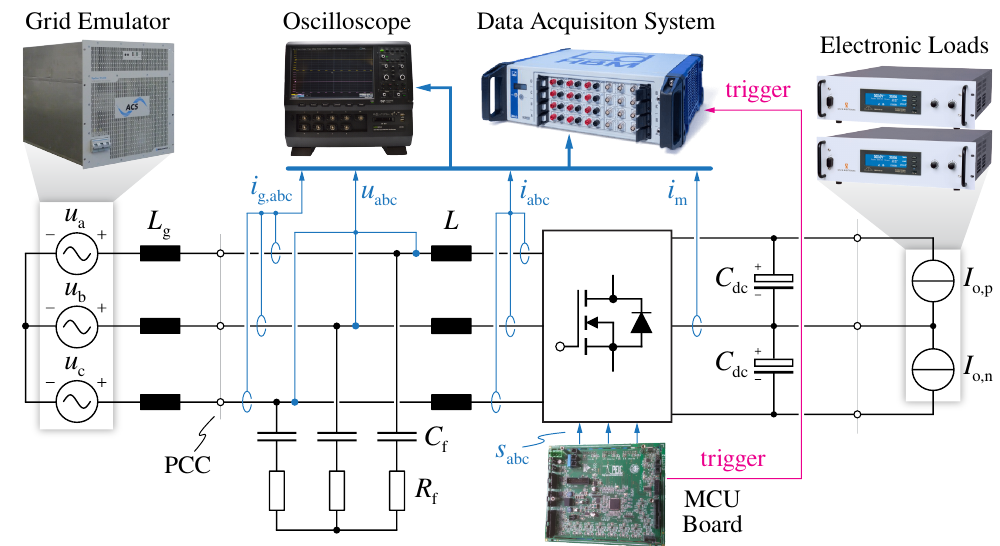
Figure 12. Simplified schematic diagram of the experimental